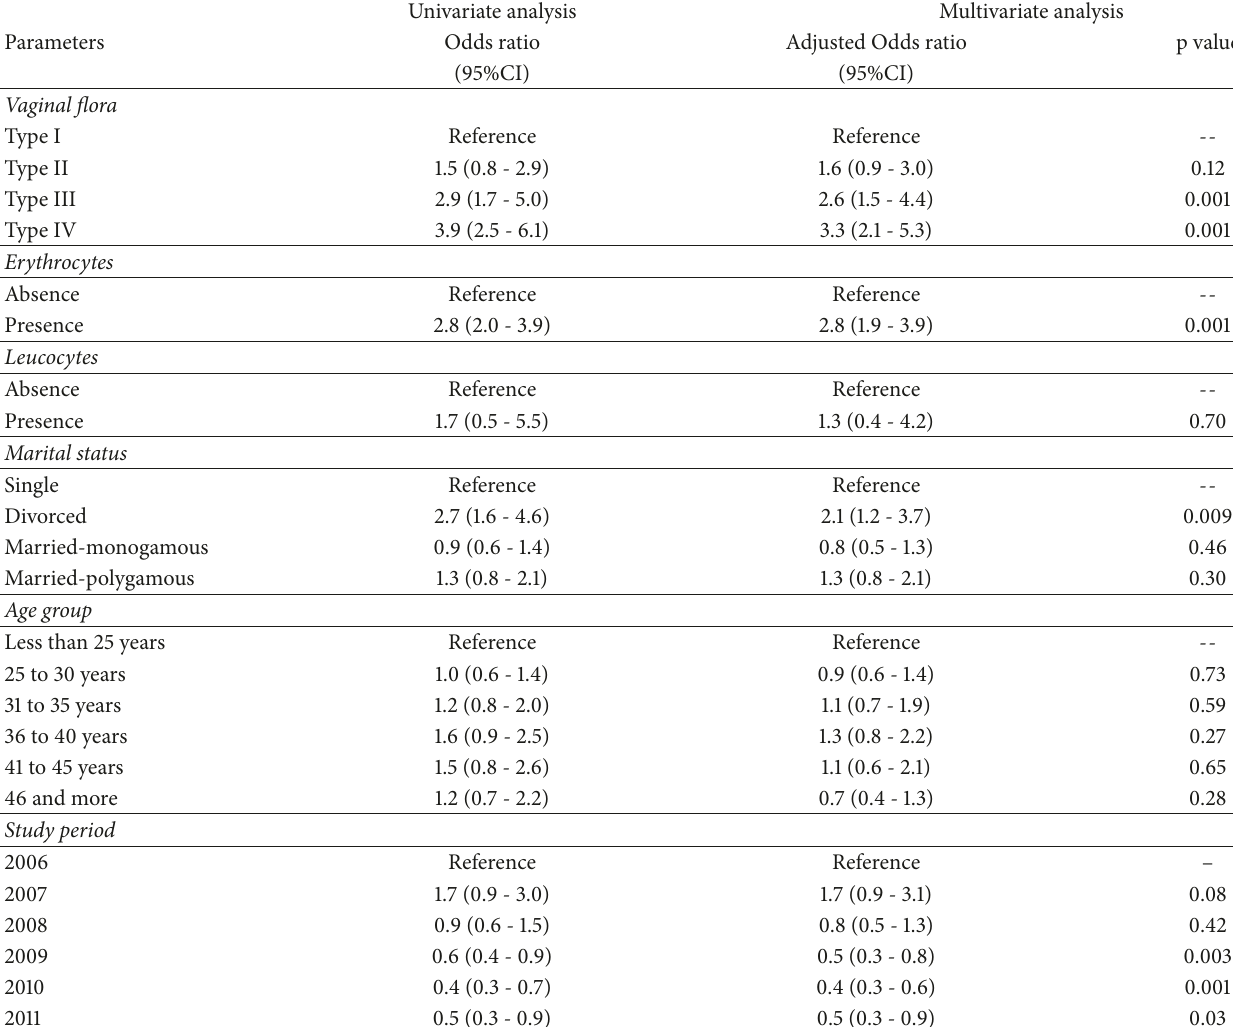
Table 5: Factors associated with Trichomonas vaginalis infection among participating